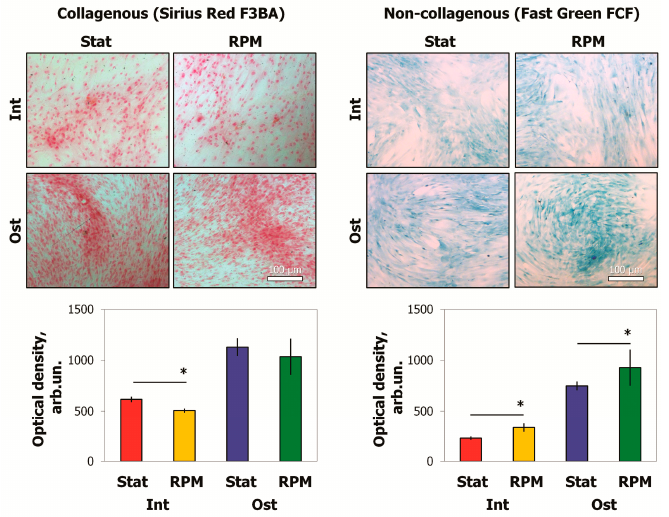
Figure 7. Evaluation of collagenous and non-collagenous proteins of MSCs after 10 days of RPM exposure, light microscopy (bright field), and spectrophotometry. Sirius Red F3BA and Fast Green FCF selectively bind collagenous and non-collagenous components of ECM, respectively. Data are presented as mean ± SD; n ≥ 3, * p < 0.05. MSCs—mesenchymal stromal cells; Int—intact MSCs; extracellular matrix.